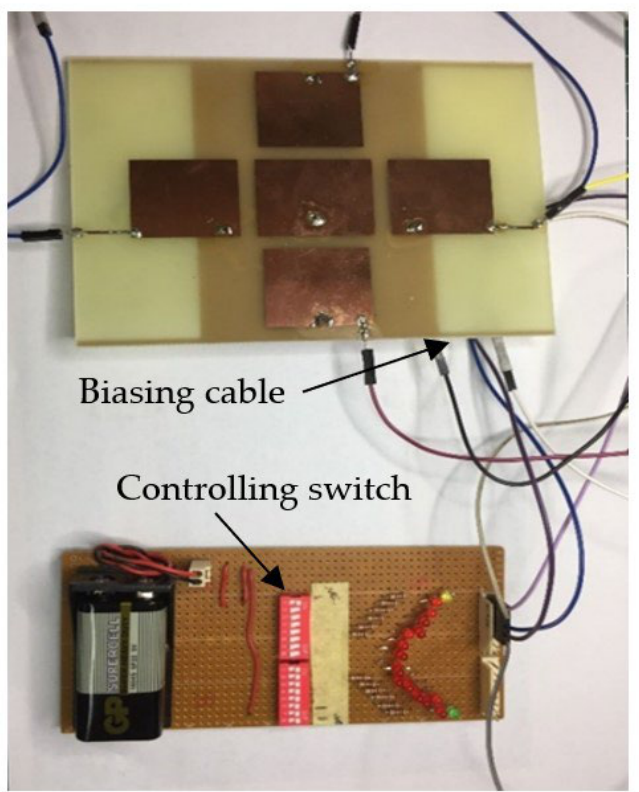
Figure 4. Front view of the optimized design of four - element parasitic with integration of biasing network for RF switches.